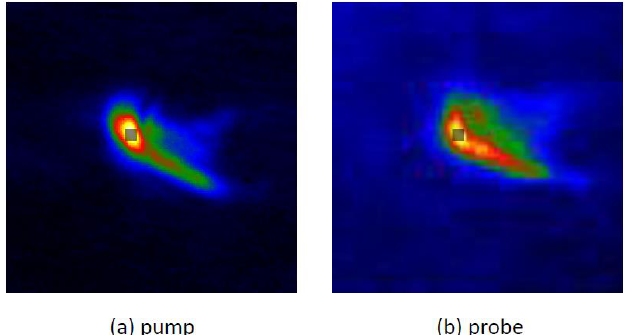
Figure 5. Measurement area selection. Fe-3p resonant pump ( a ) and Ni-3p resonant probe ( b ) diffracted intensity from the Ni-ferrite sample. The two images are shown on different color scales. The gray square represents the 7 × 7 pixels area used for Ni-magnetization analysis, where the pump fluence is assumed to be homogeneous.